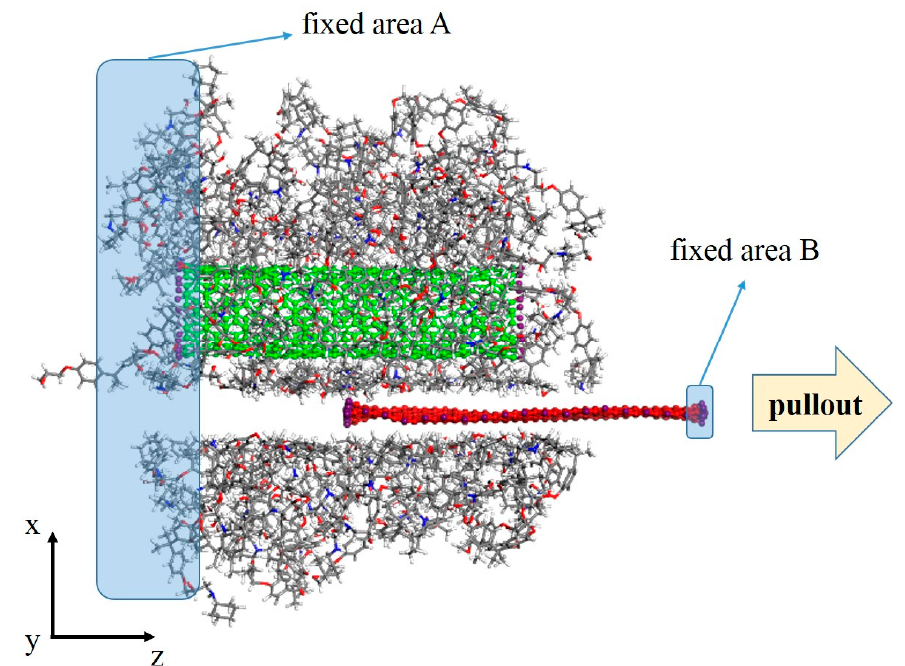
Figure 2. Schematic diagram of the graphene pullout process from the composite model.